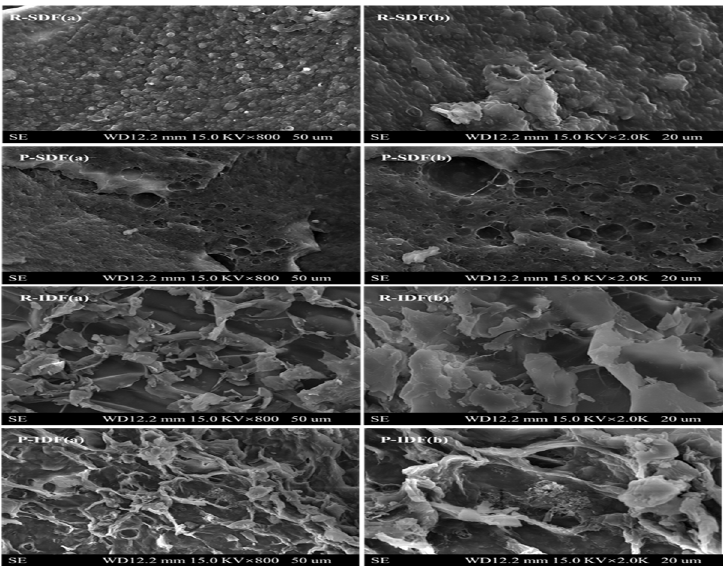
Figure 1. SEM images for R-SDF ( a , b ), P-SDF ( a , b ), R-IDF ( a , b ) and P-IDF ( a , b ); ( a , b ) represent the micrographs taken at the small and large magnification, respectively. R-SDF represents the residue soluble fiber; P-SDF represents the peel soluble fiber; R-IDF represents the residue insoluble fiber; P-IDF represents the peel insoluble fiber.